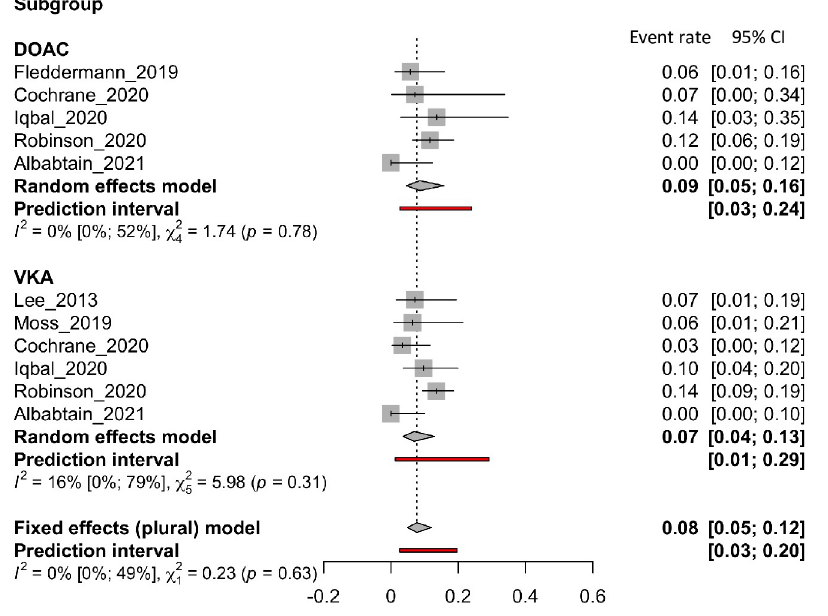
Fig 7. Forest plot of the proportion of all-cause death rate for VKA and DOAC therapy.